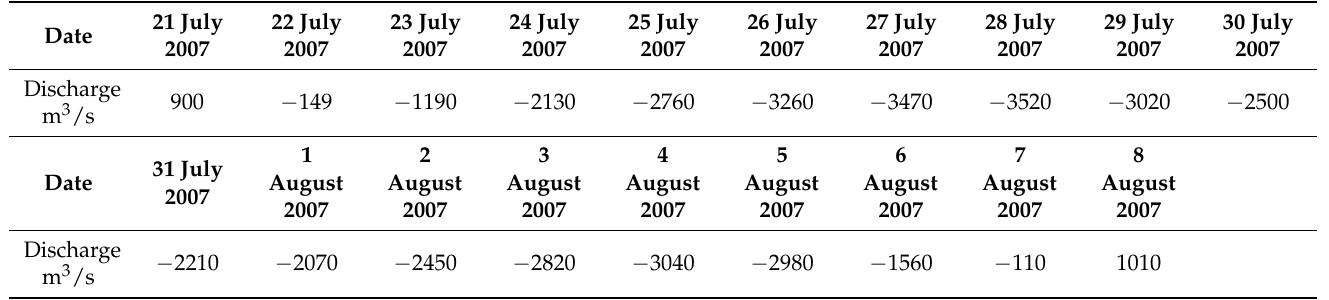
Figure 9. Schematic processing of the backflow from river to lake (BRL) from 22 July to 7 August 2007. Line 1 and Line 2 are the locations of the mutation lines at the beginning and end of the BRL, and the filled area is the influence scope of this BRL. Table 2. The observation discharge data of Hukou hydrological station from 21 July to 8 August 2007.